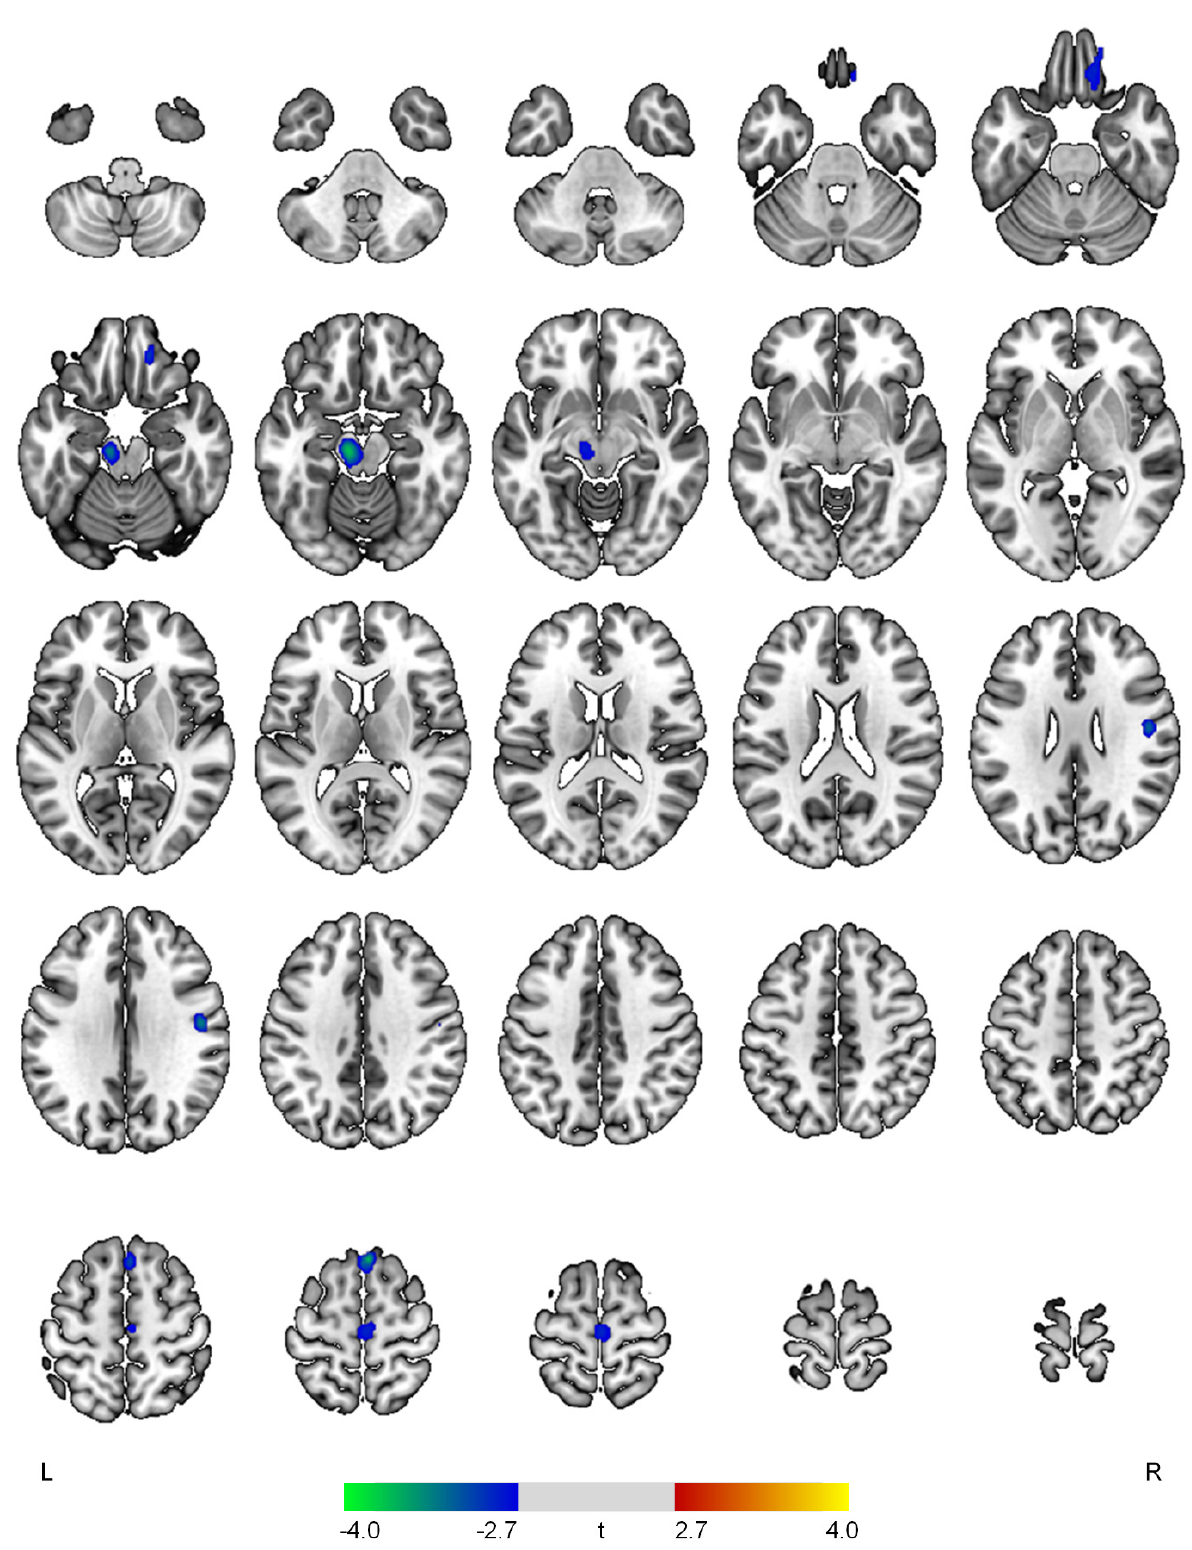
Figure 2. Positive (red-yellow) or negative (blue-green) correlations between regional cerebral blood flow and the apathy domain in patients with early Alzheimer’s disease. The color bar represents t values at each voxel. L —left; R —right.